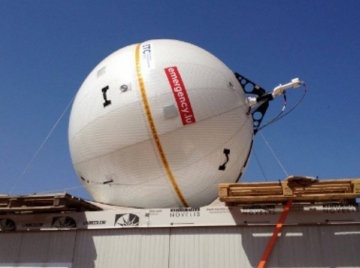
Figure 3. B-LiFE deployment in N’Zerekore, Guinea: view of the satellite communication antenna (2.4 m inflatable Ground Antenna Transmit and Receive (GATR); www.gatr.com, accessed on 17 February 2021, obtained from–SES-Soci é t é Europ é enne des Satellites, Betzdorf, Luxembourg) placed on the roof of the B-LiFE command and control